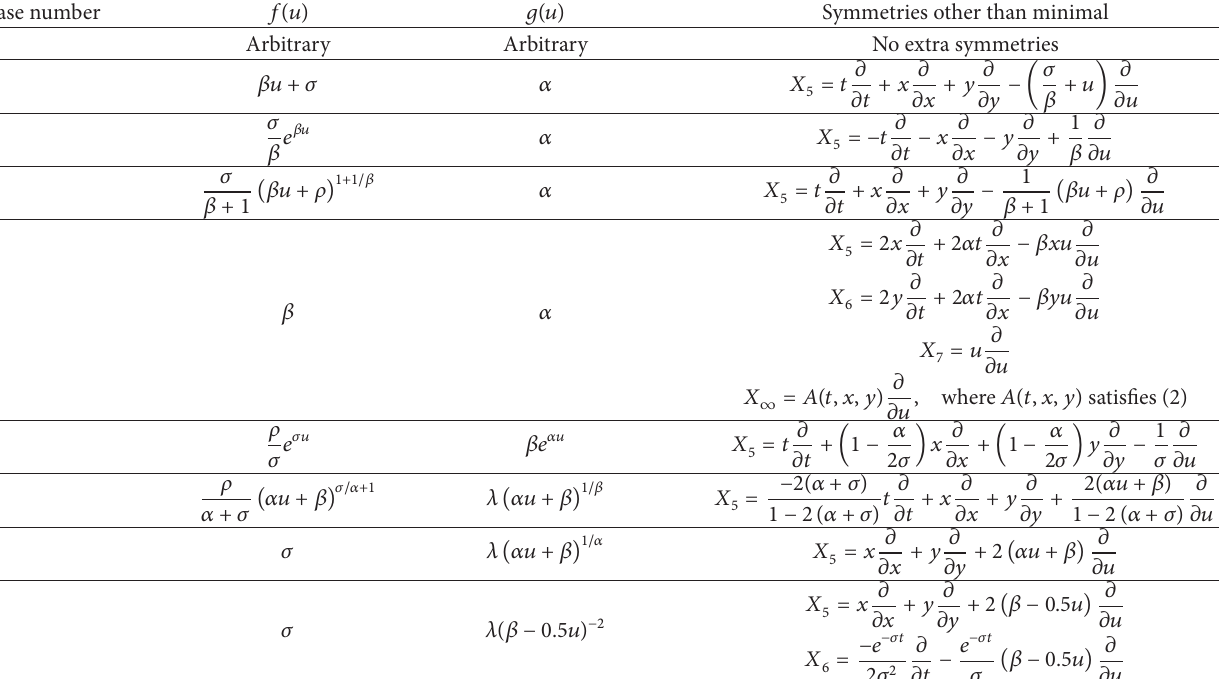
Table 1: Symmetries other than minimal of (2) for particular forms of 𝑓 and 𝑔